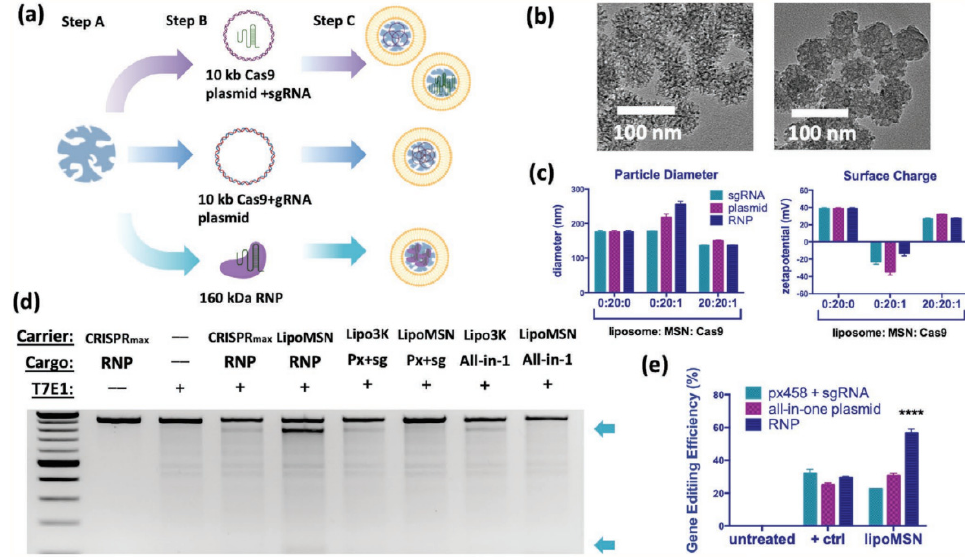
Figure 9. In vitro design and optimization diagram of CRISPR delivery and gene editing in liver, using MSN coated with liposome as a carrier. ( a ) The liposome loading capabilities of gene editing substance. ( b – e ) The characteristics of CRISPR delivery system **** p < 0.0001. Reprinted with permission from Ref. [96]. Copyright 2020 John Wiley and Sons.